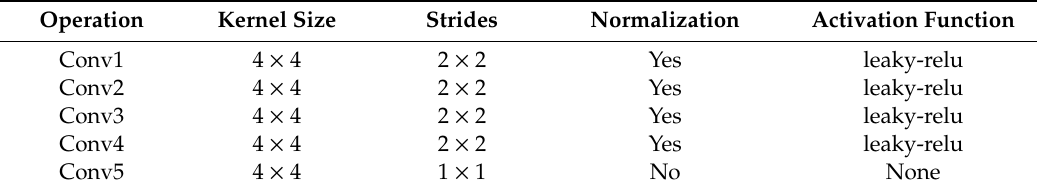
Table 2. The framework of D y and D x.